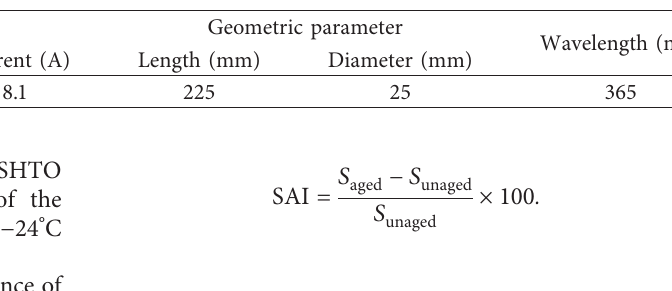
Table 5: Technical parameters of 1000W high-pressure mercury